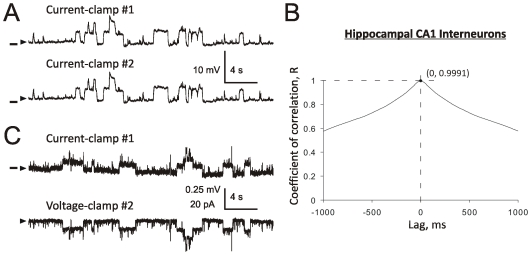
Analysis of cross-correlations and space-clamp in hippocampal CA1 interneurons.An example of traces recorded by two patch-clamp electrodes in current-clamp (A). Results of cross-correlation analysis (B). The correlation coefficient at lag = 0 ms (R = 0.9991) was used to estimate the significance of cross-correlation between the two traces (see Methods). Results obtained in the same experiment when electrode #2 was switched to voltage-clamp at −80 mV (C). Electrode #1 remained in current-clamp and detected small (∼0.12 mV) space-clamp errors (C, top trace) in the quality of voltage-clamp provided by electrode #2. Horizontal bars indicate the membrane voltage of −79 mV (A) and −79.4 mV (C). A continuous hyperpolarizing current (50–120 pA) was injected into cells to cease spontaneous firing (A). The baselines are indicated by arrowheads.